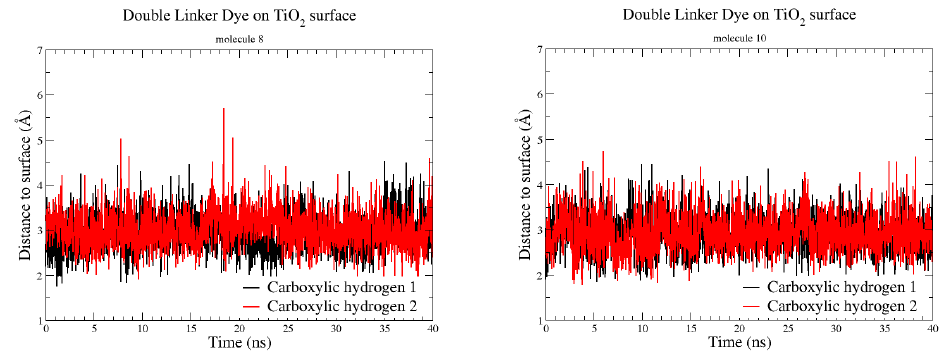
Figure 5. Distances between carboxylic hydrogens and TiO 2 surface over the 40 ns molecular dynamics (MD) simulation.